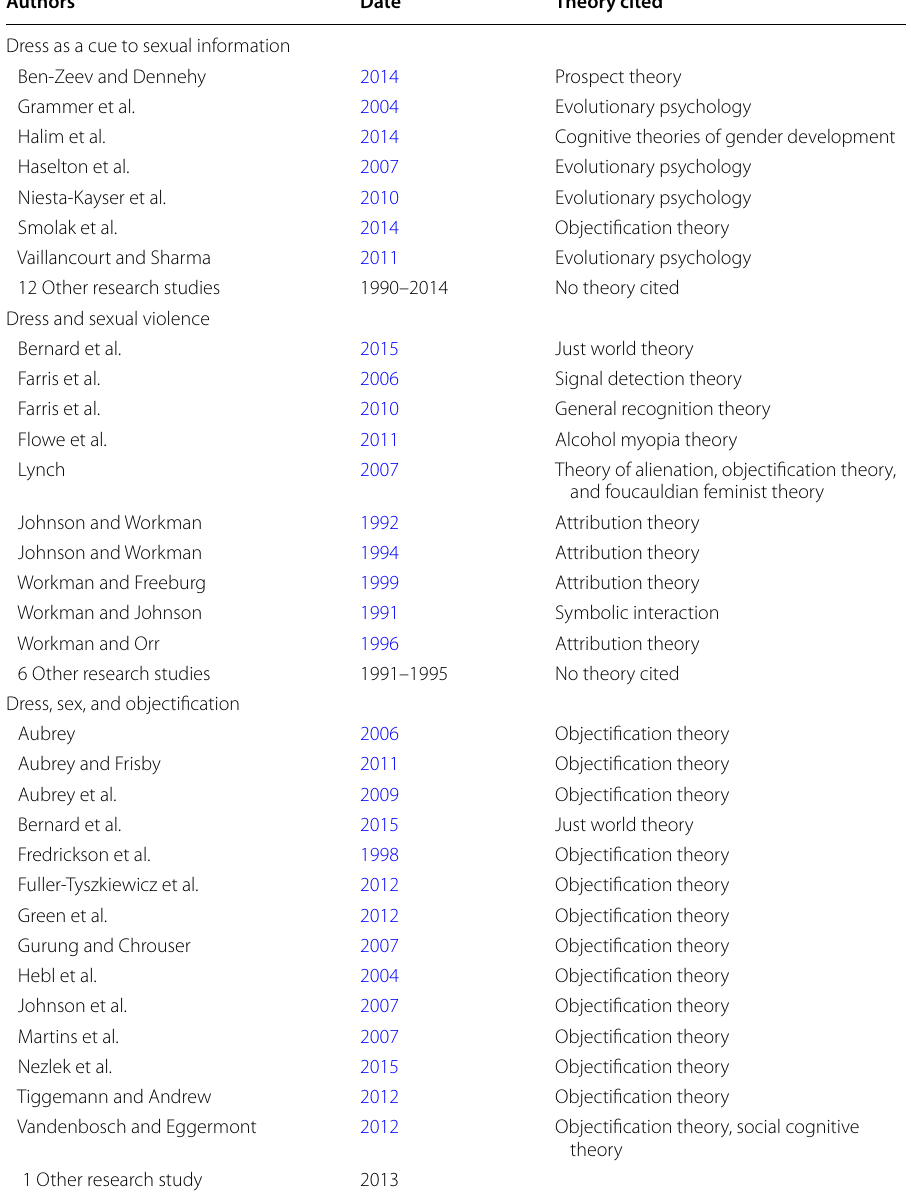
Table 1 Authors, dates of publication, and theories cited in each of the three topical